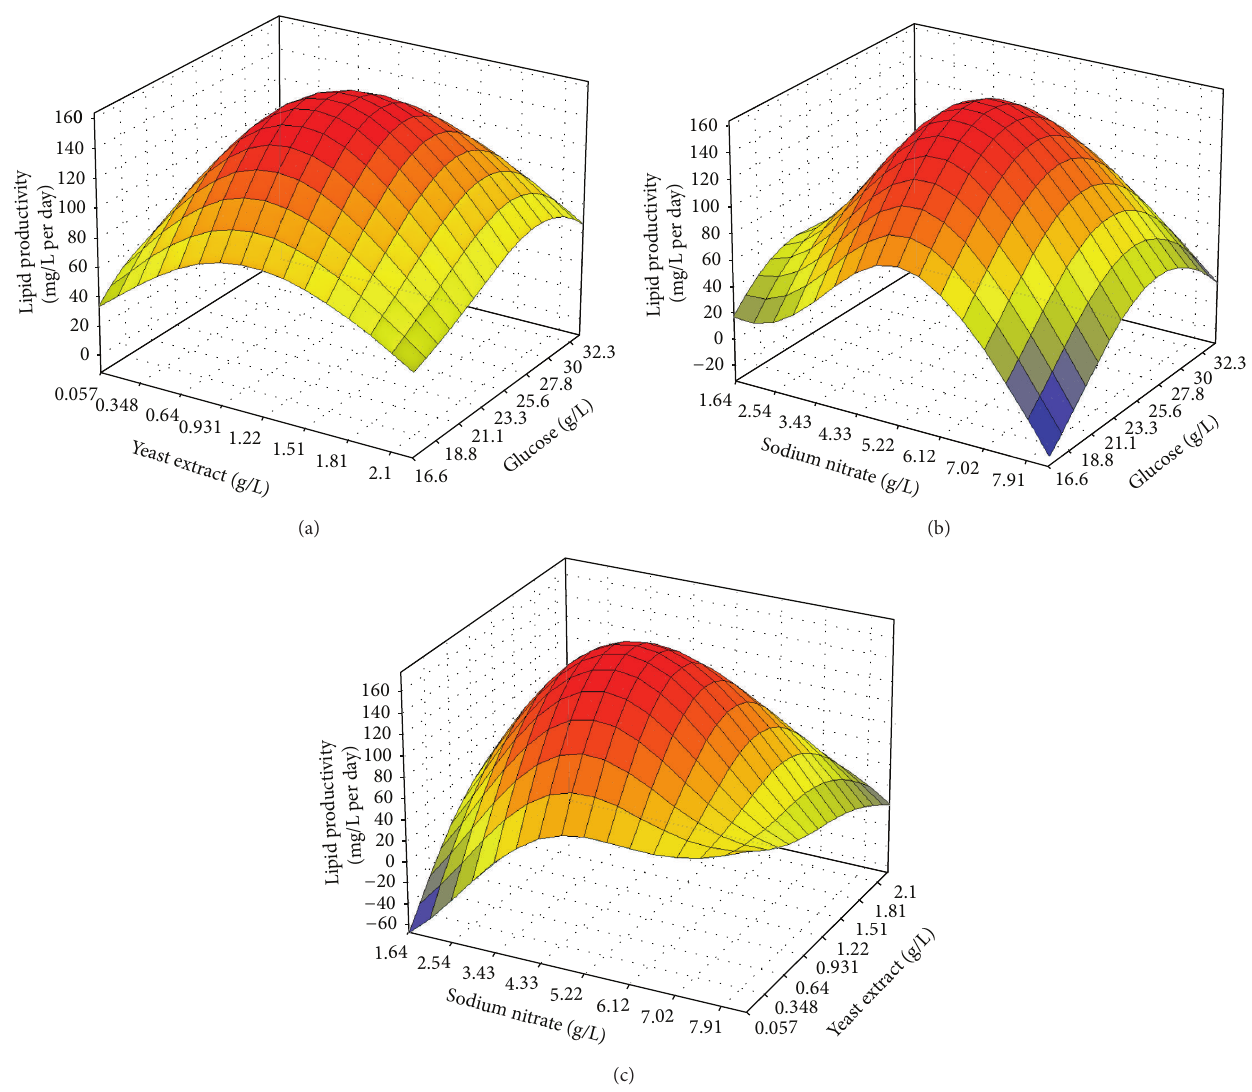
Figure 4: Response surfaces with regard to lipid productivity showing the interactions between (a) yeast extract with glucose, (b) NaNO 3 with glucose, and (c) NaNO 3 with yeast extract as modeled via neural